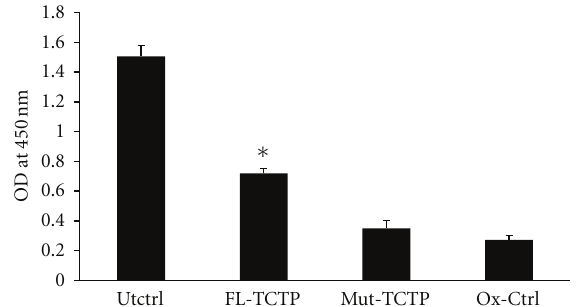
Figure 4: Over expression of TCTP conferred resistance to H 2 O 2 damage in mammalian cells. Cos1 cells were over expressed with wild type (FL-TCTP) or mutant TCTP (Mut-TCTP) and exposed to 100 µ M H 2 O 2 for 24h in culture. Following incubation, cell viability was determined colorimetrically. Cells transfected with vector alone and exposed to the same conditions (O x -Ctrl) or without exposure to H 2 O 2 (Utctrl) served as controls. Results show that mutation of TCTP at the SUMO motif significantly reduced its antioxidant function. ∗ P < 0 . 01 compared to